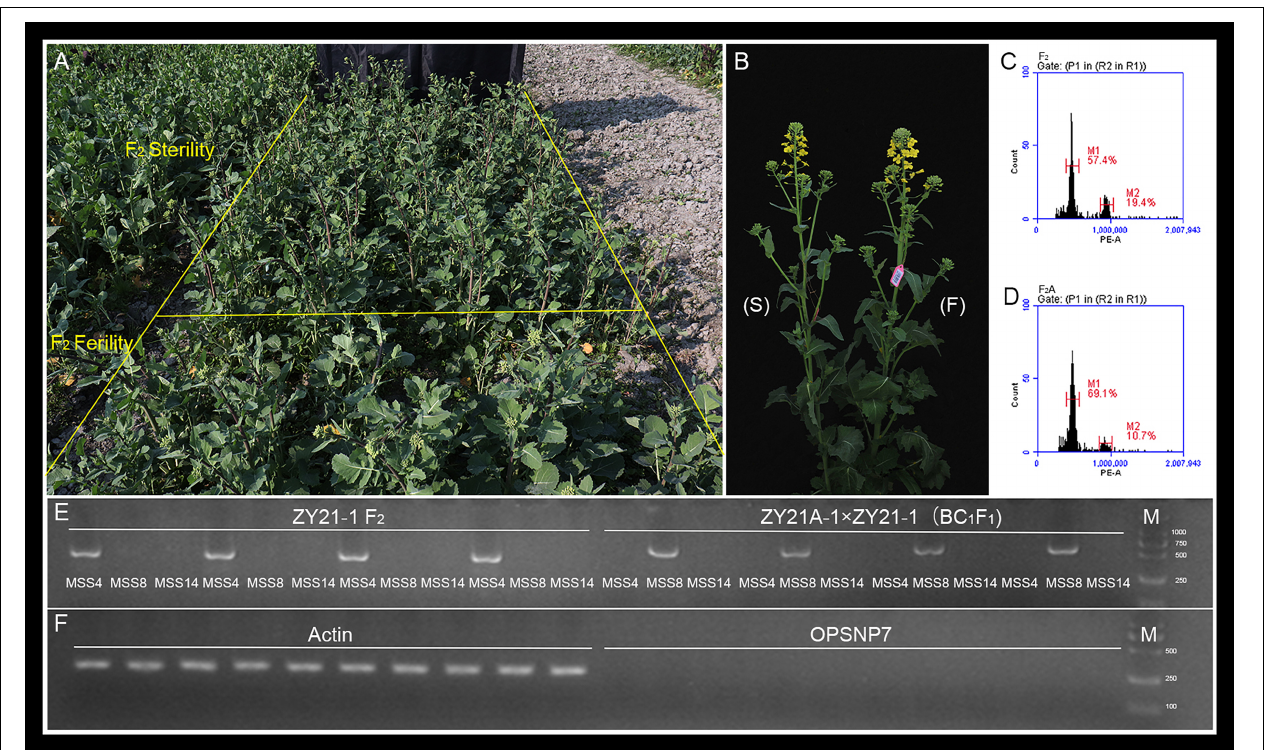
FIGURE 4 | Identification results of different fertility populations (ZY21-1 F 2 and ZY21A-1 × ZY21-1 (BC 1 F 1 ) in the induced F 2 generation. (A) Plant phenotypes of the induced F 2 generation populations (ZY21-1 F 2 and ZY21A-1 × ZY21-1 (BC 1 F 1 )) with different fertility populations. (B) Plant phenotypes of the different fertile progeny of the induced F 2 generation population (ZY21-1 F 2 and ZY21A-1 × ZY21-1 (BC 1 F 1 )), “F,” the fertile progeny ZY21-1 self-crossed F 2 generation; “S,” the sterile progeny ZY21A-1 × ZY21-1 sister-crossed in the BC 1 F 1 generation. (C) Flow cytometry results of induction of F 2 generation plant of ZY21-1 self-crossed. (D) Flow cytometry results of induction of BC 1 F 1 generation plant of ZY21A-1 × ZY21-1 sister-crossed. (E) Molecular markers result from induced F 2 and BC 1 F 1 generation with different fertility population cytoplasm genotypes. (F) Molecular markers result of induced F 2 and BC 1 F 1 generation pol restorer gene, and actin is internal reference gene.